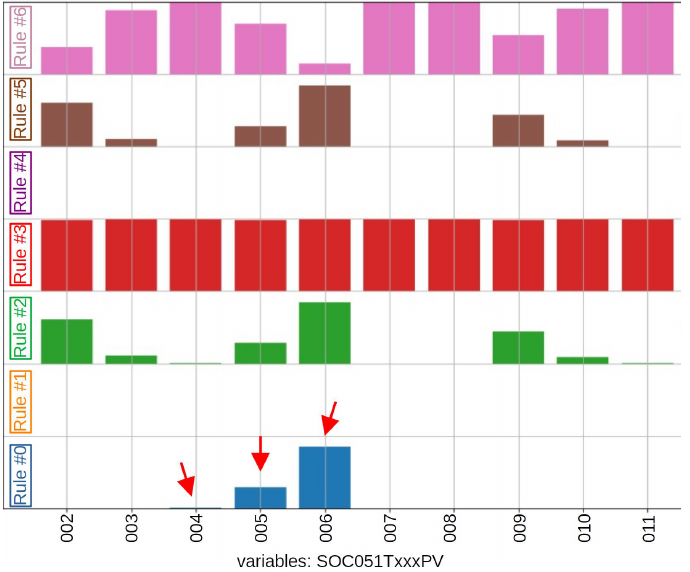
Figure 14. Bar graph of the bearings subsystem—between 17 July 2019 and 31 July